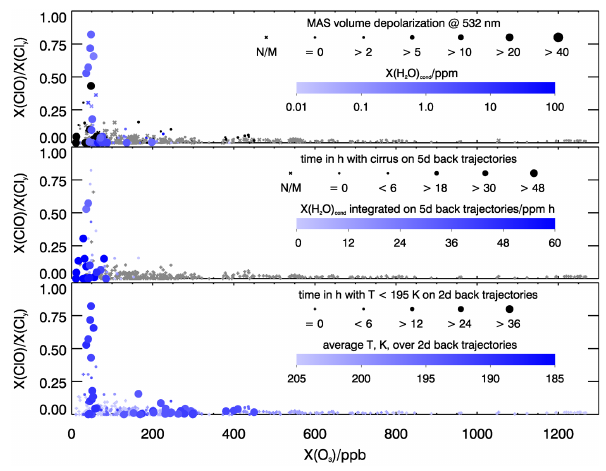
Fig. 5. ClO/Cl y ratios as a function of O 3 mixing ratio and charac- terization of the “heterogeneous chemistry potential”. Top panel: ice water content (colour code; grey: [H 2 O] cond = 0, black: no data) and volume depolarisation (symbol size; N/M: not measured) as proxies for cirrus particles; middle panel: integrated ice wa- ter content (colour code) and time with ice present (symbol size; N/M: not measured) simulated on 5 day back trajectories to es- timate the extent of cirrus occurrence preceding the flights; bot- tom panel: mean ECMWF temperatures for 2 day back trajectories (colour code) and time at T < 195K (symbol size). For uncertain- ties in X (ClO)/ X (Cl y ) cf. caption to Fig.